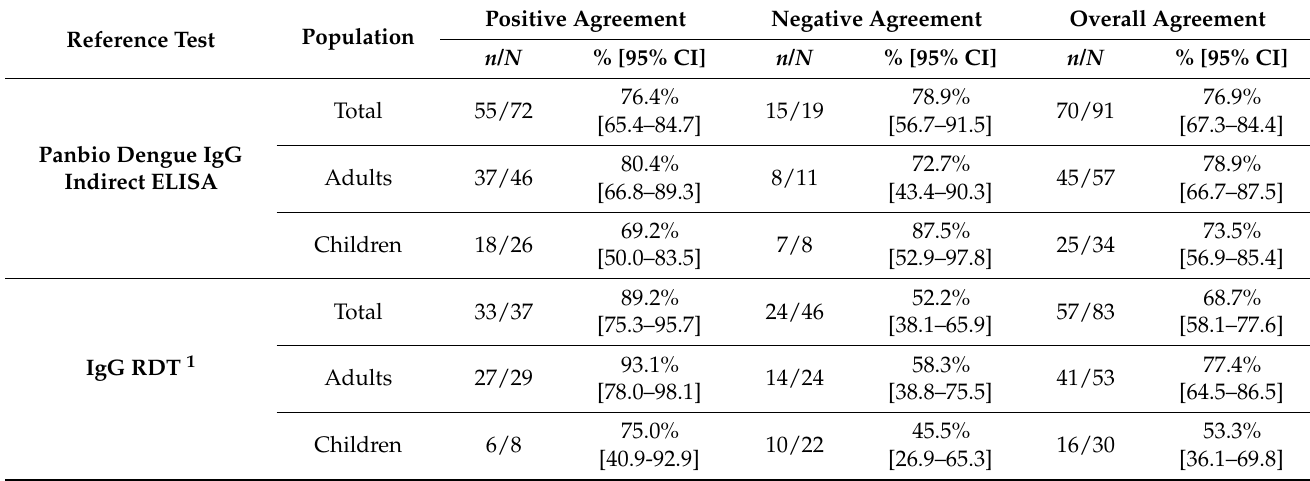
Table 5. Concordance of VIDAS ® Anti-Dengue IgG and competitor